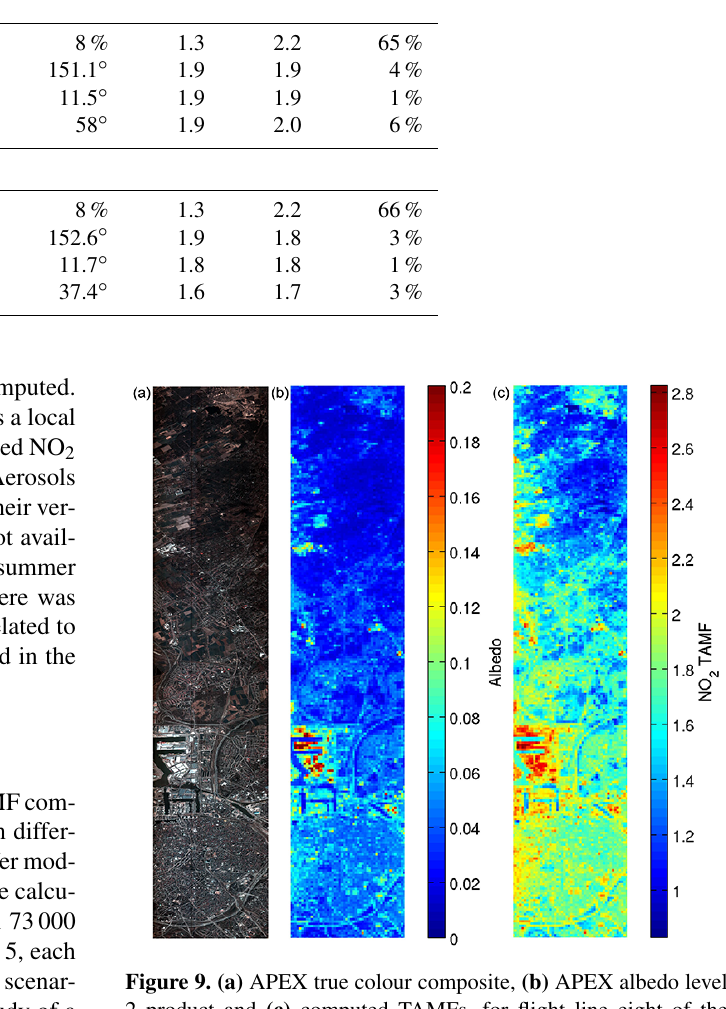
Table 5. Sensitivity study with varying input parameters in the radiative transfer model based on 73000 and 96000 observations for the Antwerp and Brussels data sets, respectively. For the albedo, sun and viewing geometry, each time two scenarios are provided based on the µ ± 1 σ level and corresponding TAMFs are derived by BAMF integration along a mean AURORA NO 2 profile. RTM Antwerp Albedo